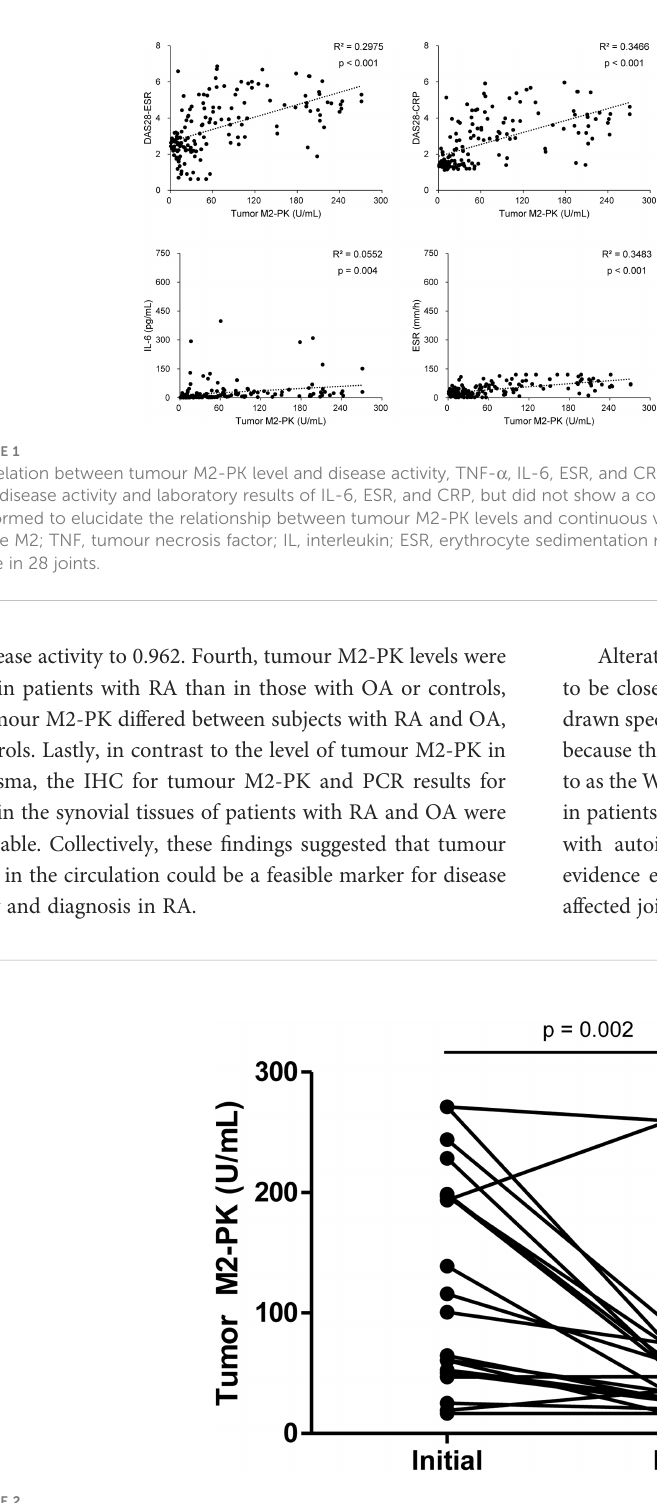
FIGURE 2 Serial testing of tumour M2-PK level after reduction in disease activity. Tumour M2-PK levels decreased signi fi cantly following improvement in disease activity. Changes in plasma tumour M2-PK levels were estimated by the Wilcoxon signed rank test. Tumour M2-PK: dimeric form of pyruvate kinase